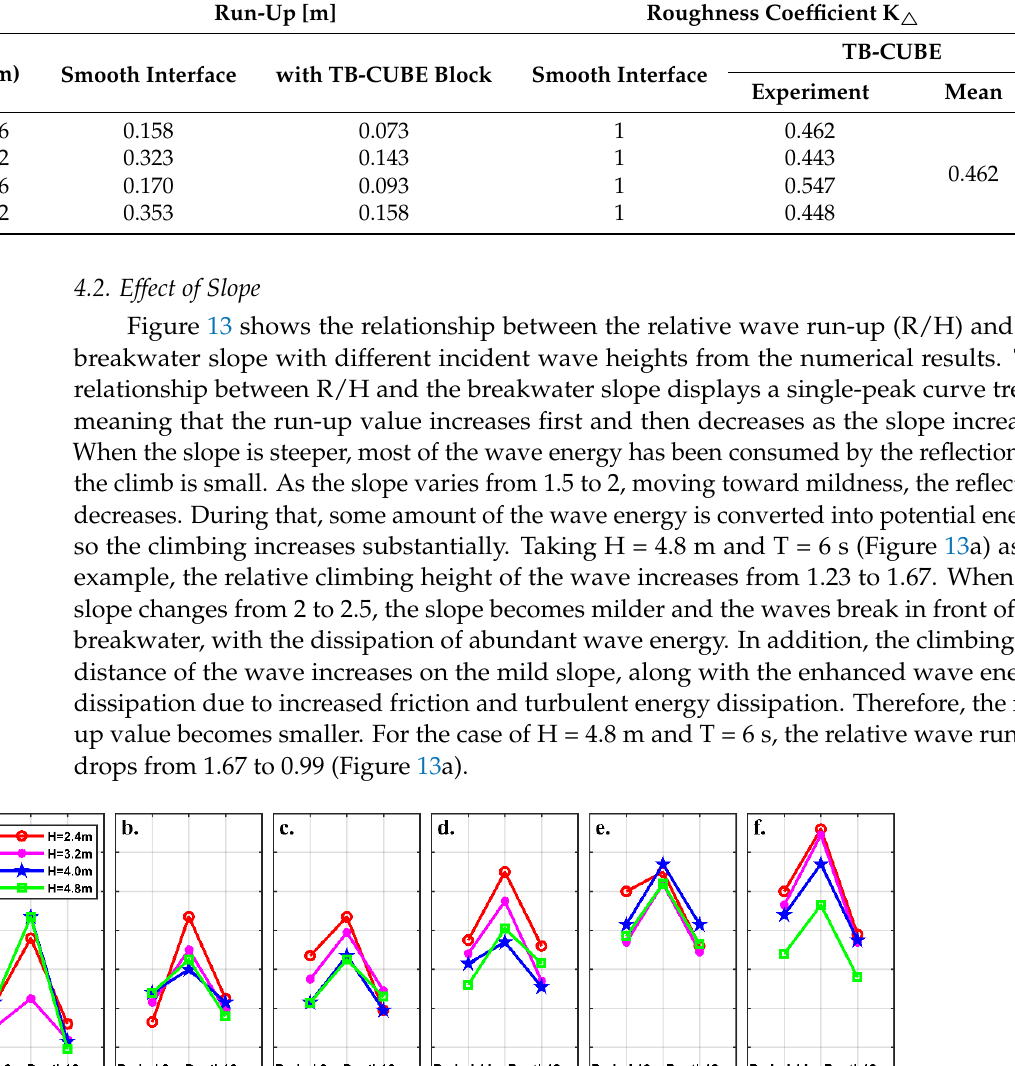
Table 5. TB-CUBE roughness-permeation parameter from the numerical model results.